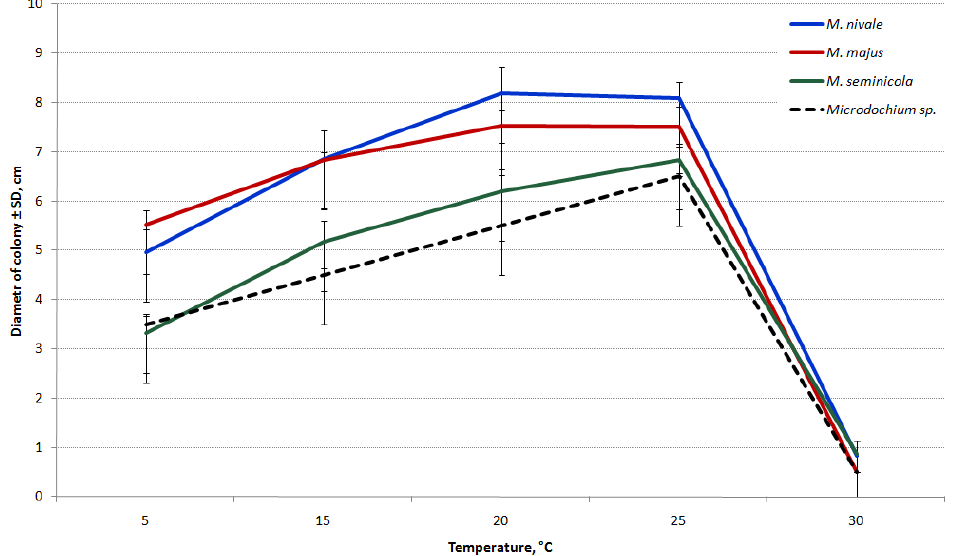
Figure 8. Growth curves of Microdochium fungi on PSA after six days of incubation at different temperatures.